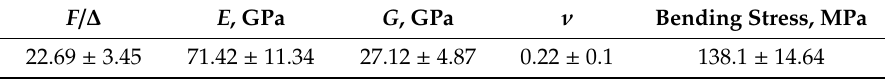
Figure 4. Bending test result of the non-strengthened glass. Table 1. Test results of E, G and ν obtained via bending test.